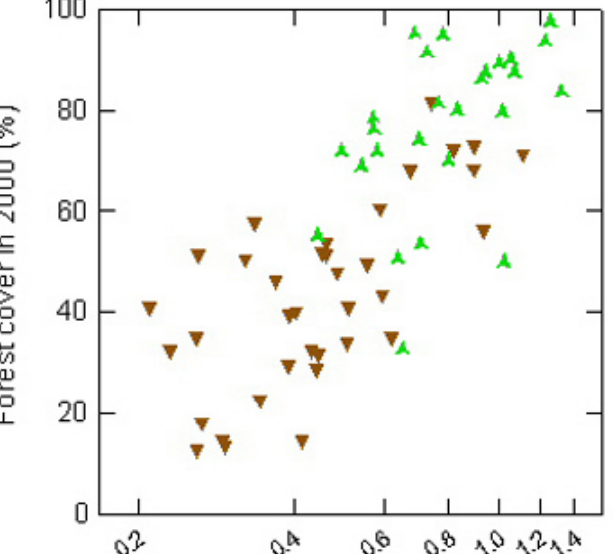
Fig. 7. The relationship between total forest cover in 2000 and the proportion of farms that lacked any form of title for 62 districts in Panama. The lack of land titles and history of deforestation explained 67.3% of the among-district variation in forest cover in 2000. Brown downward-pointing triangles indicate districts that were largely deforested before 1947; green upward-pointing triangles indicate districts that were largely forested in